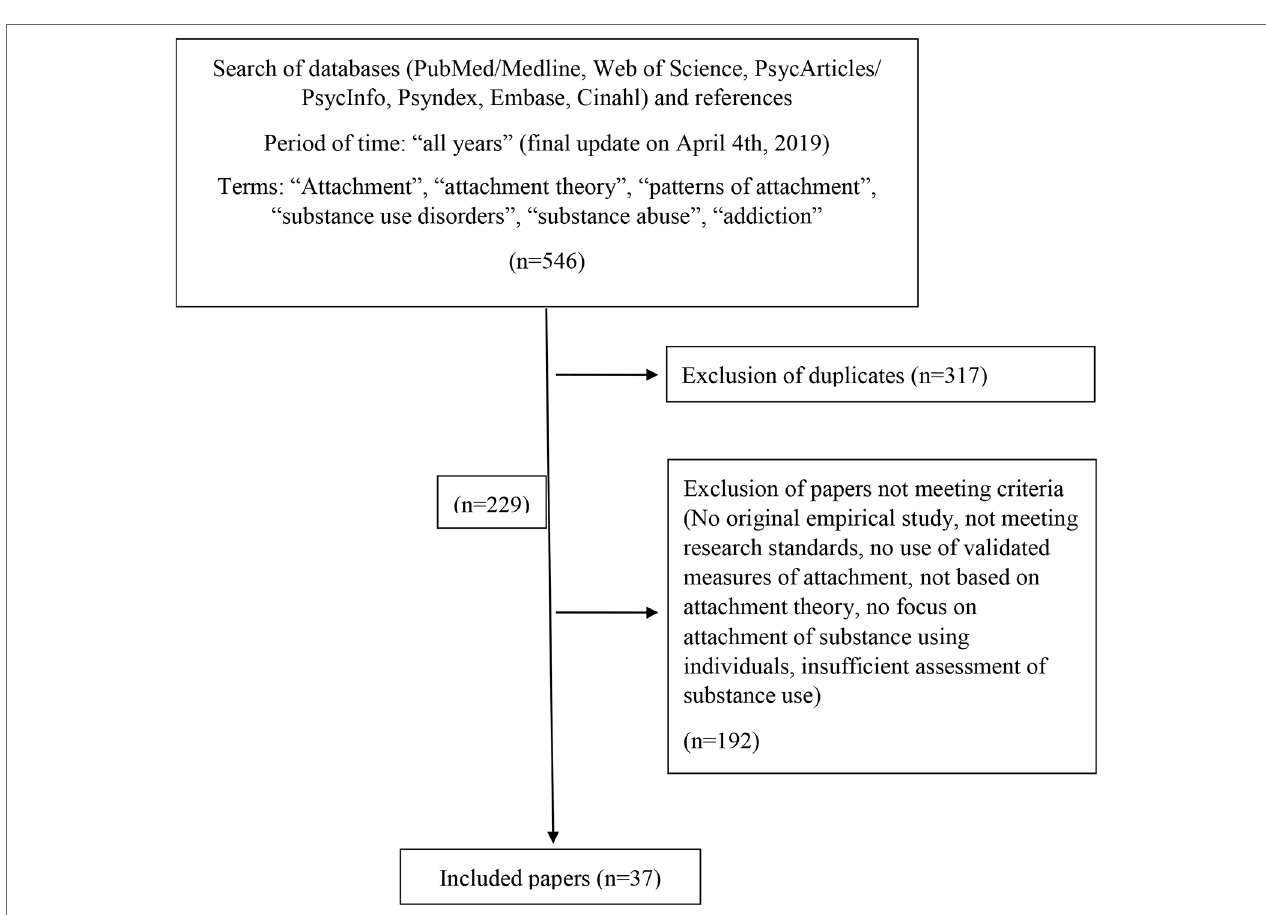
FiGURe 2 | Flowchart study